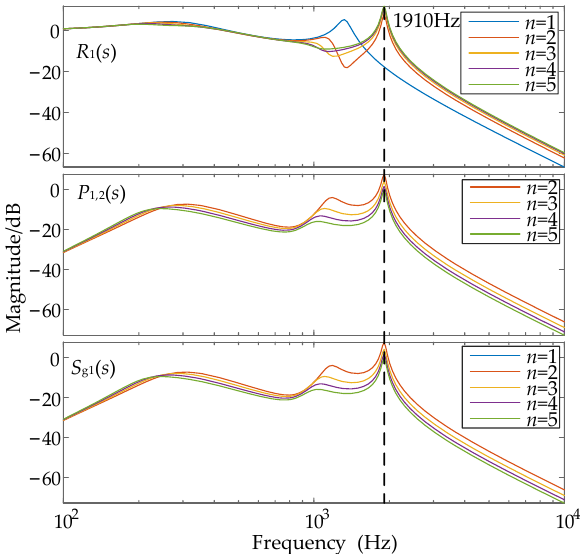
Figure 10. The characteristics of the amplitude-frequency response of each command of the inverter’s grid-connected current.